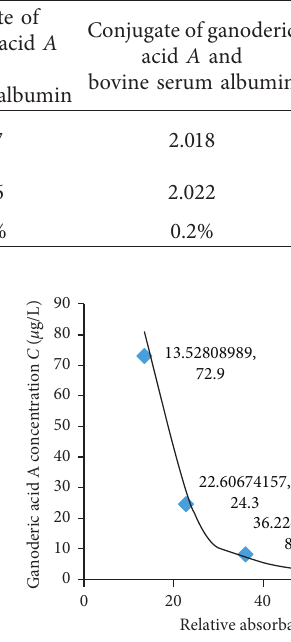
Table 2: Test results of five kinds of coating antigens.